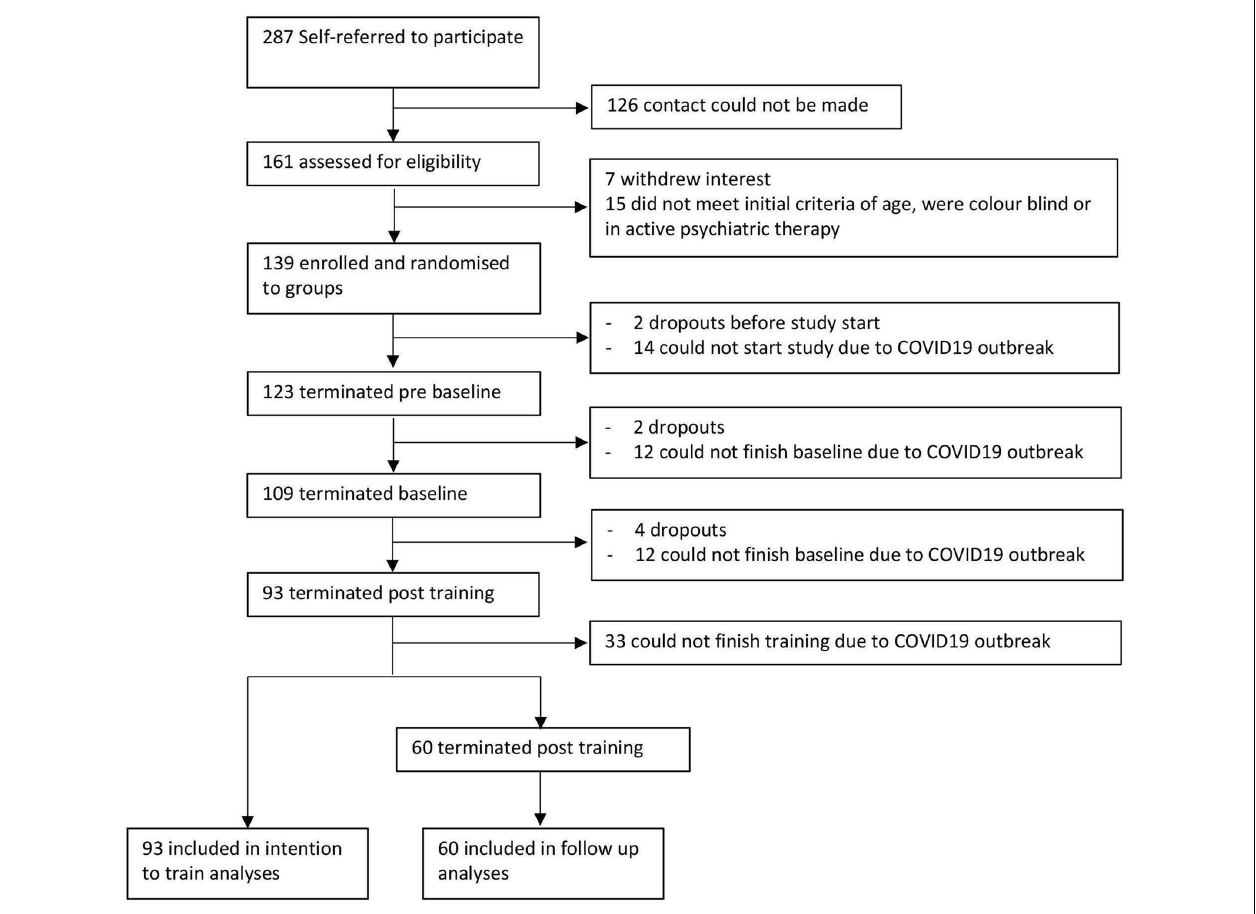
FIGURE 2 | Flowchart of participant recruitment and study inclusion.